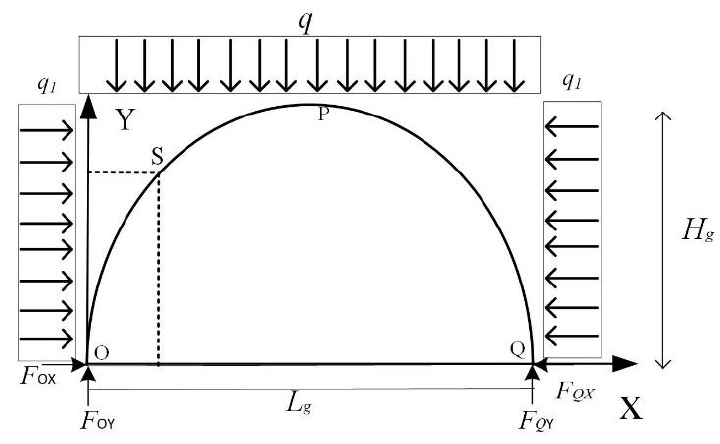
Figure 8. Mechanical model of structural